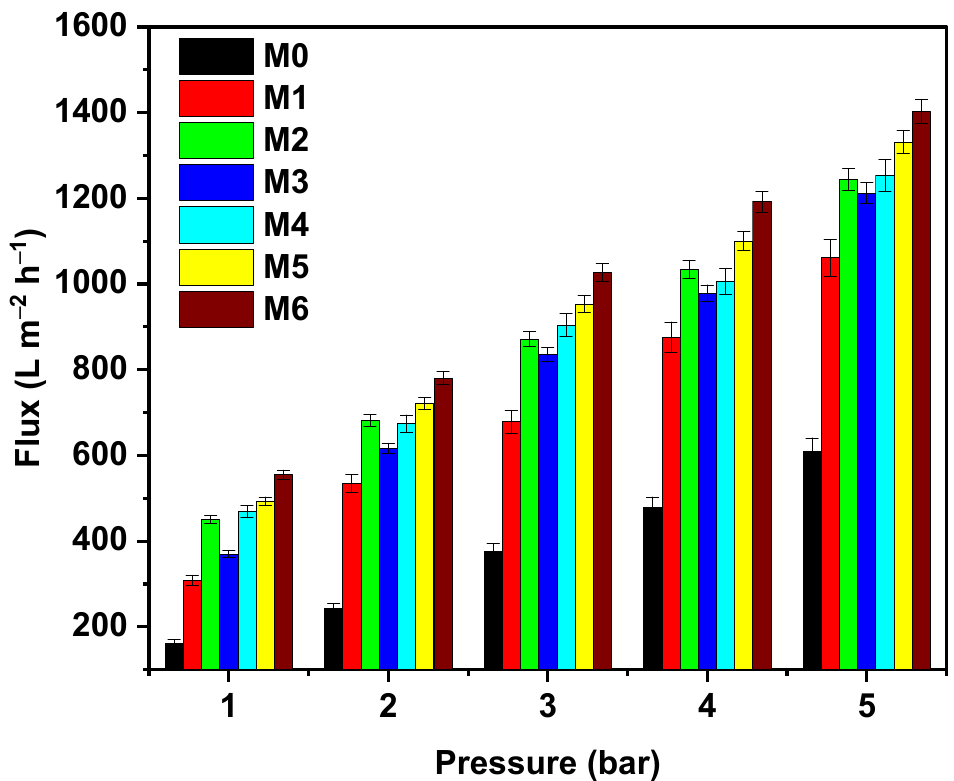
Figure 7. Influence of applied operating pressure on the water flux for bare PES, PES/MWCNTs, and PES/GO membranes.